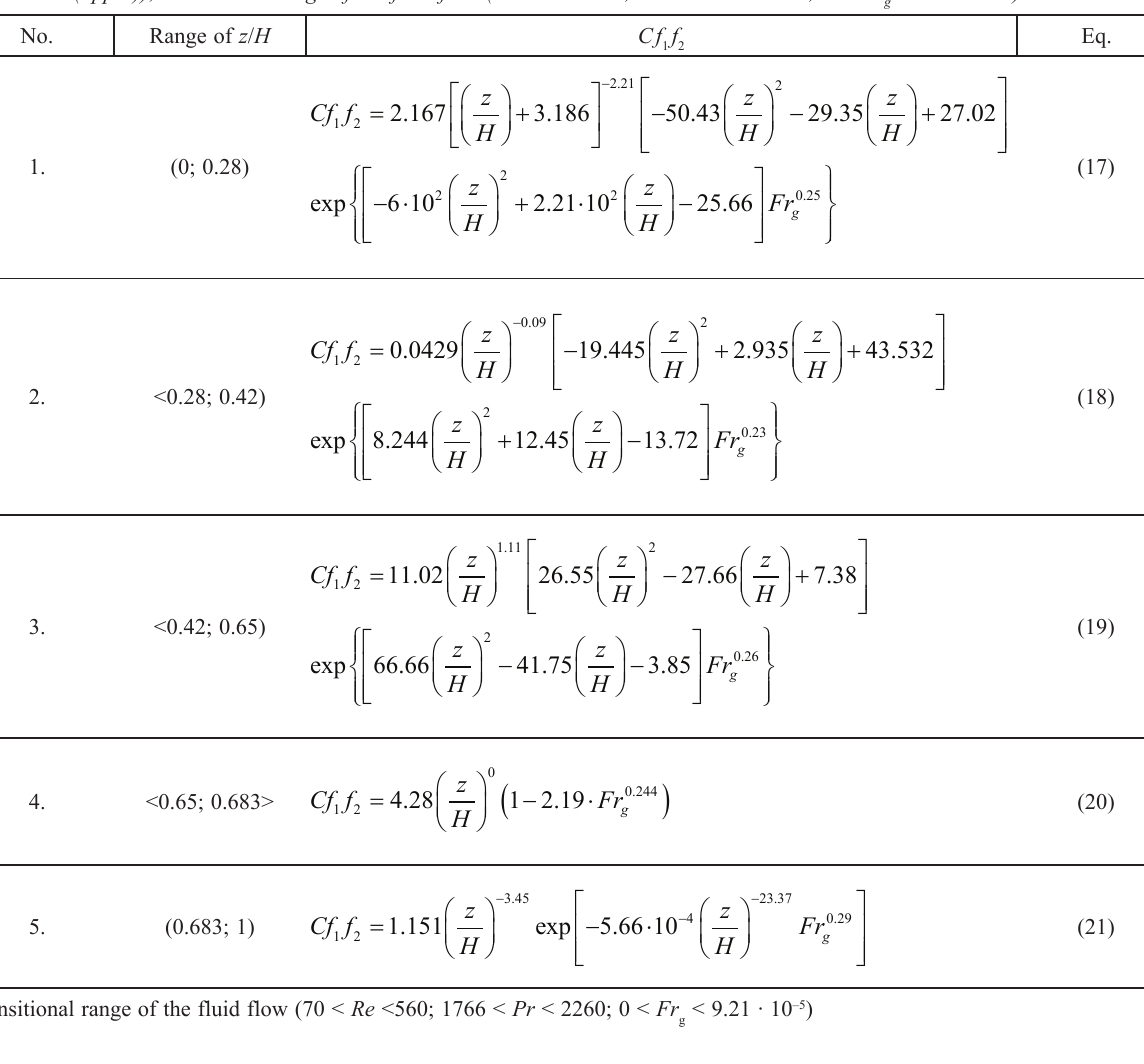
Table 2 – Functions Cf f in Eq. (12) for gas­liquid systems agitated using two impellers on a common shaft (A 315 (lower) – RT 1 2 (upper)); transitional range of the fluid flow (70 < Re <560; 1766 < Pr < 2260; 0 < Fr No. Range of z / H C f